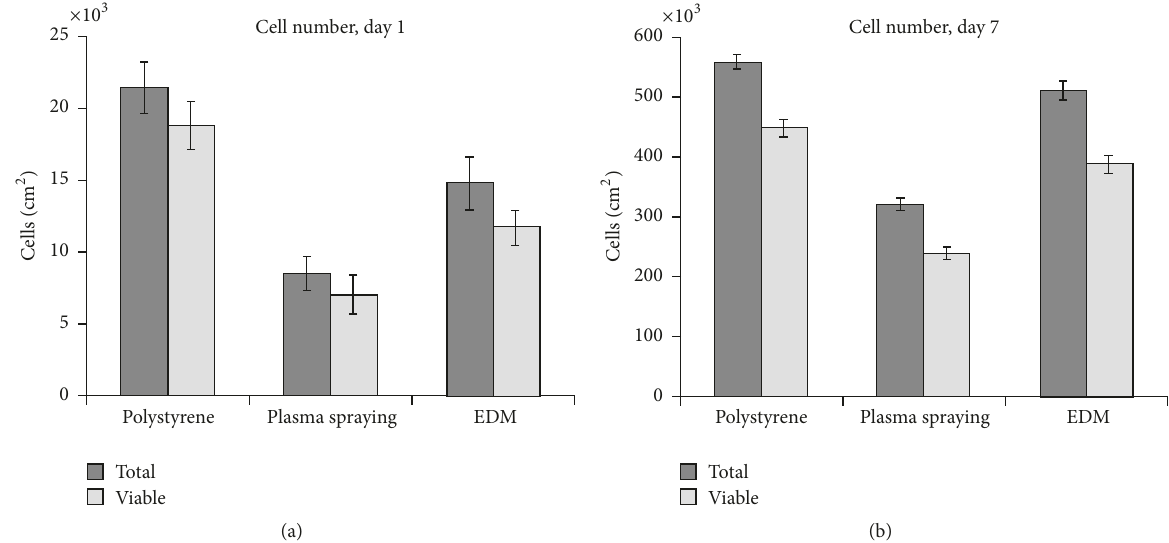
Figure 20: A quantity of human osteoblast-like cells for a Ti-6Al-4V alloy treated by plasma-spraying with TiO 2 and EDM seeded on standardized cell culture polystyrene dishes for day 1 and day 7 [157].